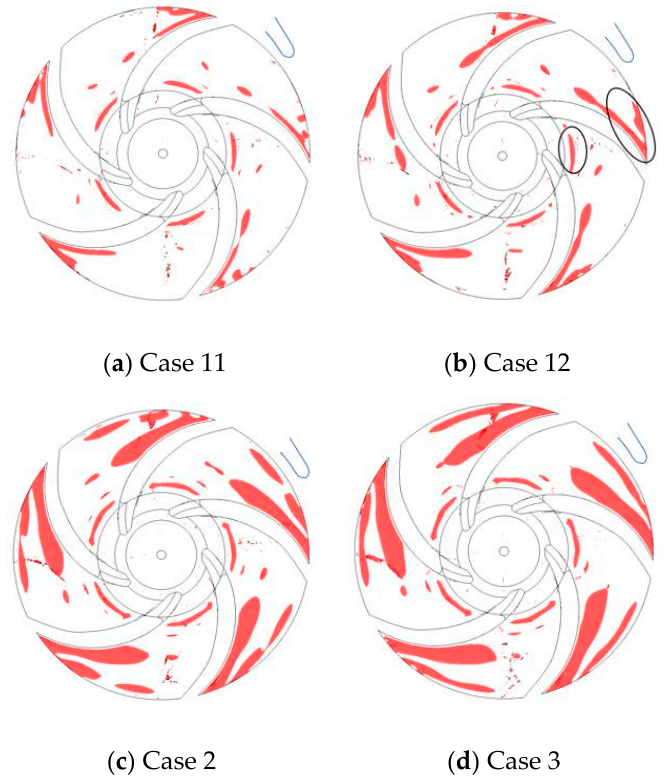
Figure 10 . Distribution of the energy gradient function K in the increasing flow rate section ( K max = 30).